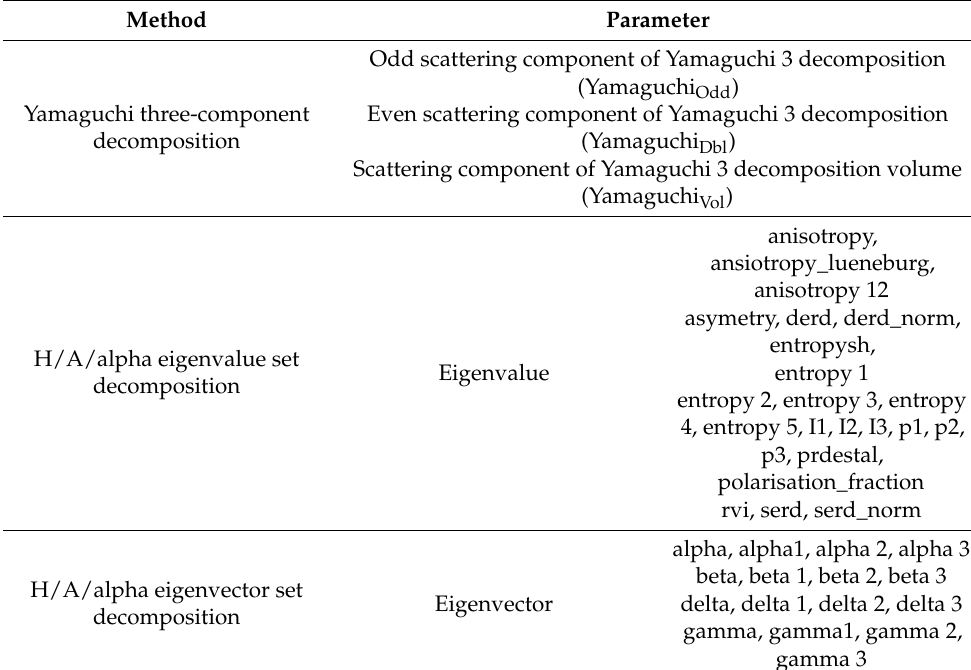
Table 2. Decomposition parameters.